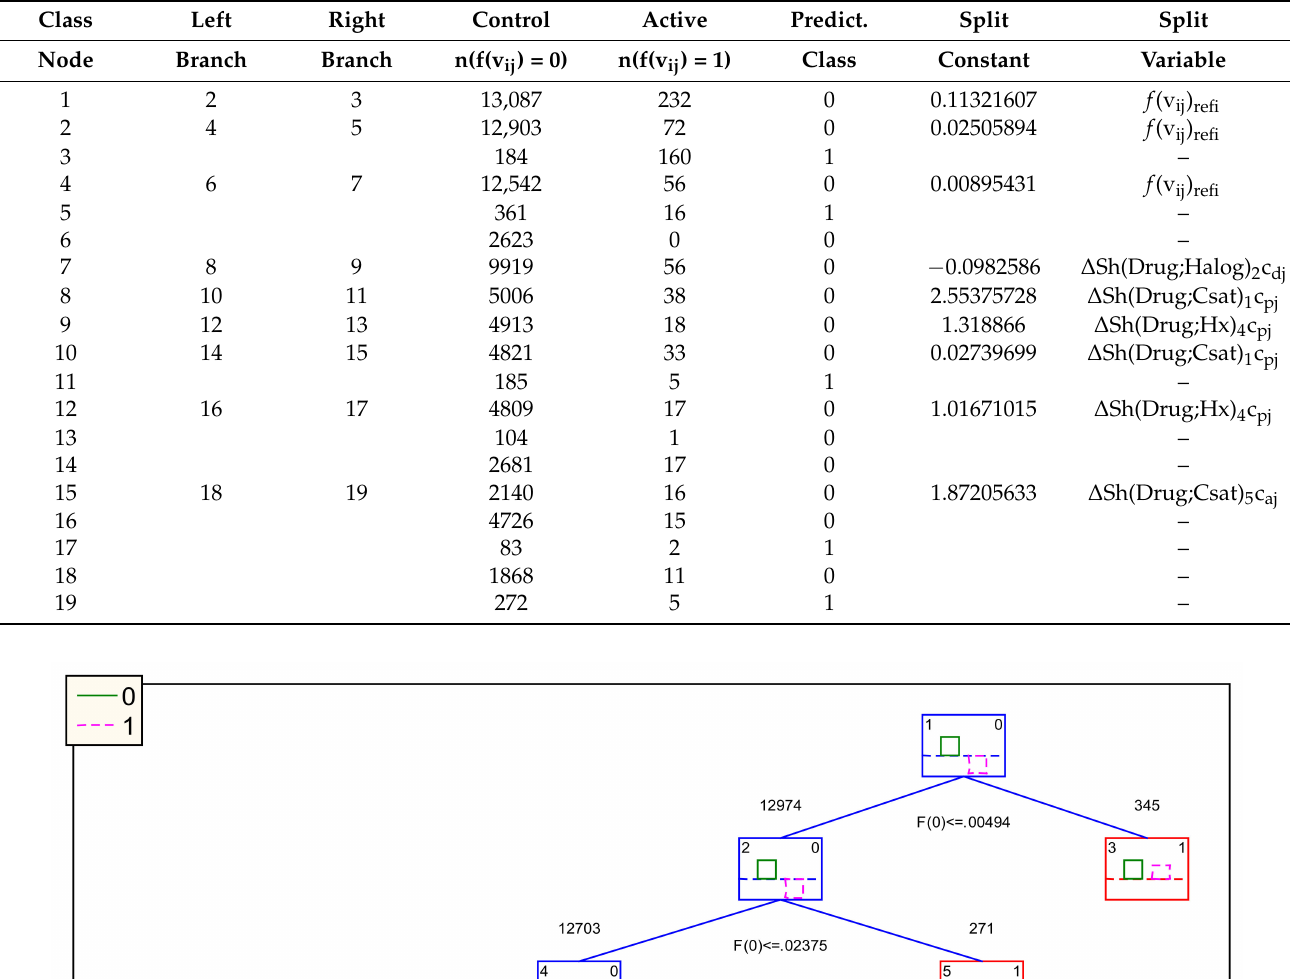
Table 3. IFPTML-CTUS model coefficients.